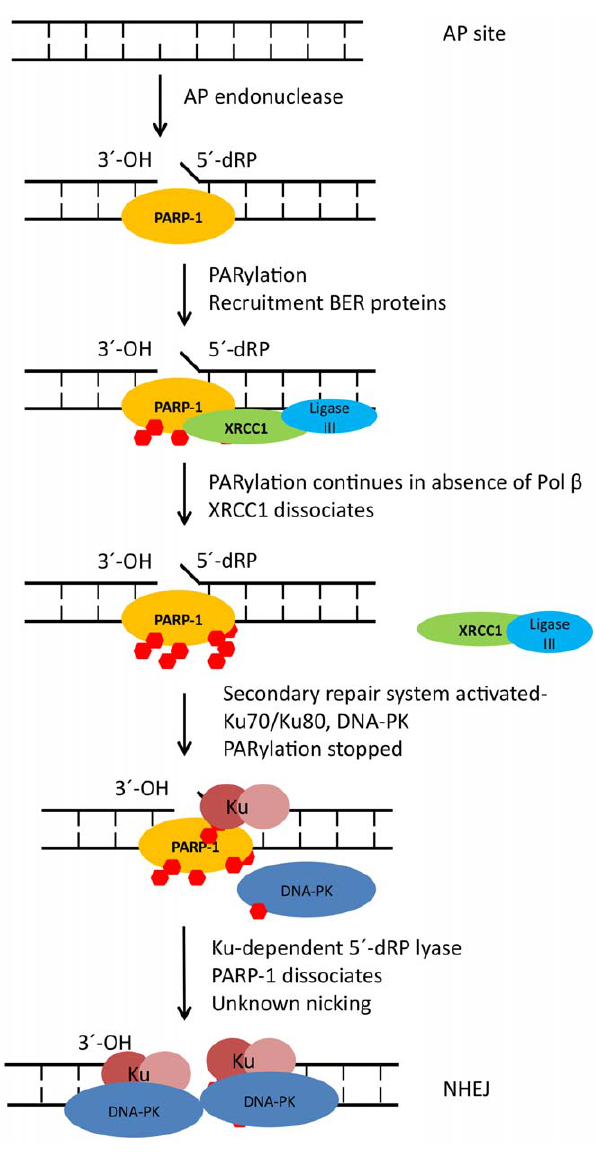
Figure 7. Model of PARP-1 hyperactivation and recruitment of NHEJ